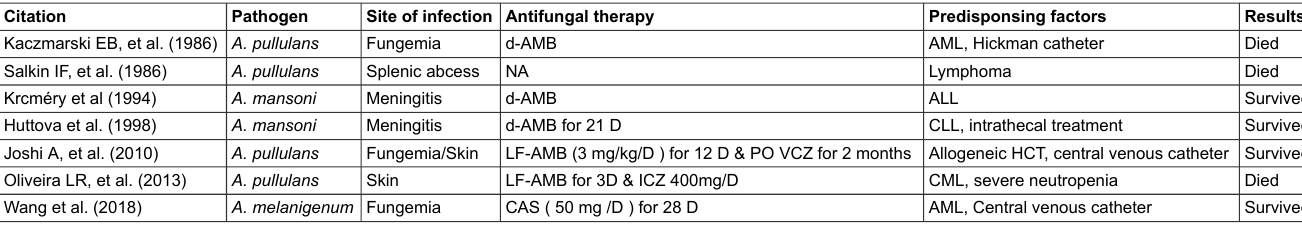
Table 1: Case reports of hematological patients with infections due to Aureobasidium spp